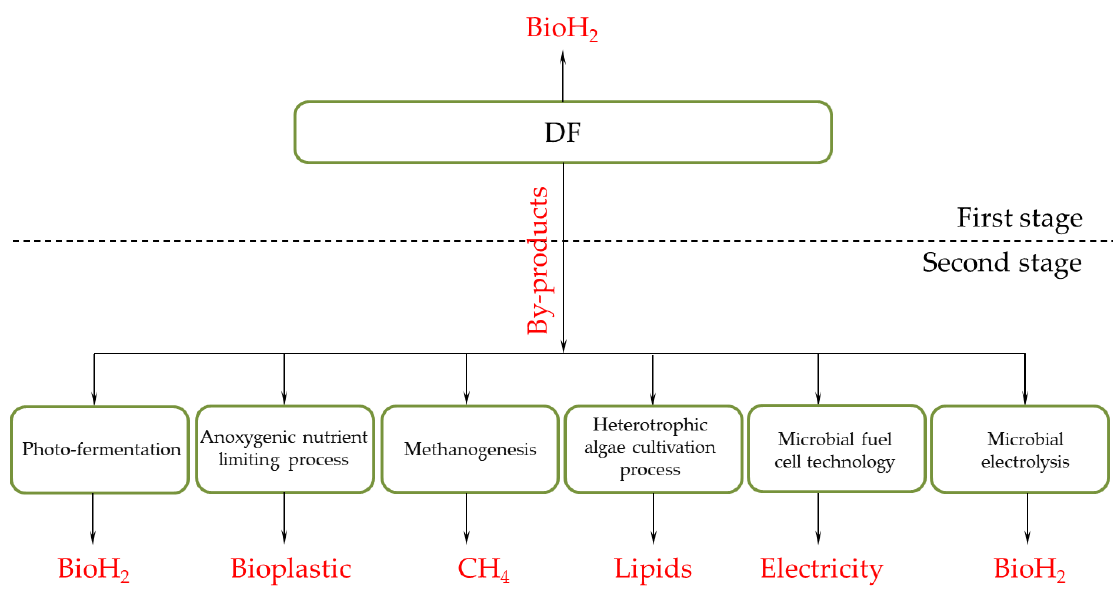
Figure 4. Various secondary bioprocesses coupled with DF to obtain valuable products [81].